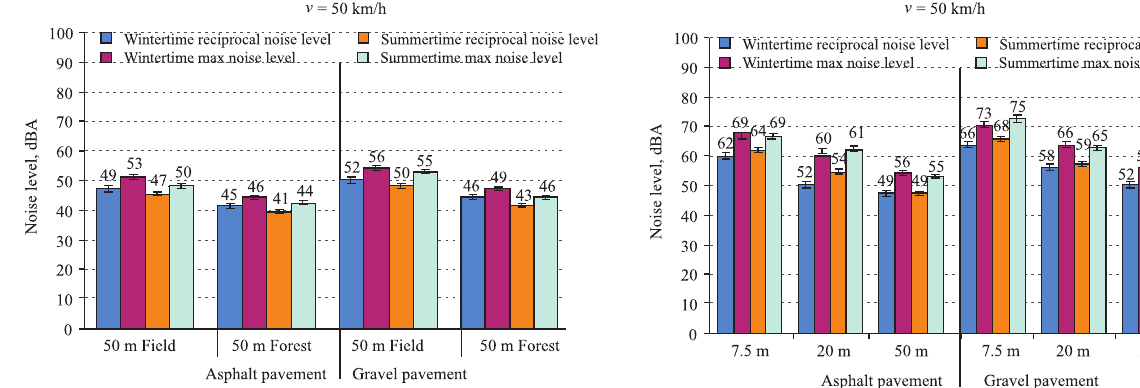
Fig. 5. Th e reciprocal and the max noise levels spread dependence on landscape conditions